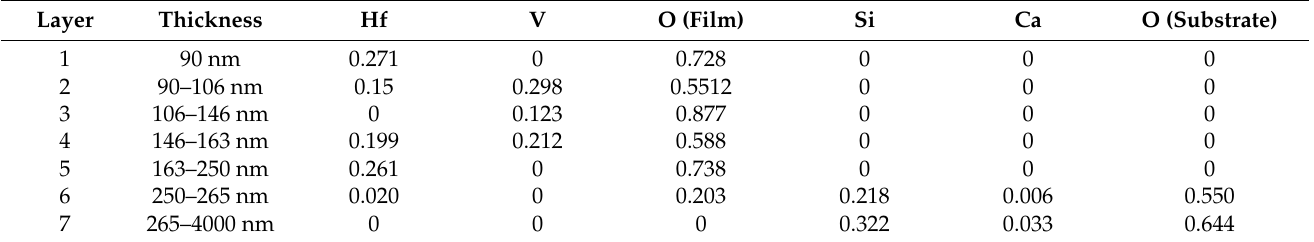
Table 3. In-depth profiling of a 300 ◦ C annealed sample’s thickness and its elemental